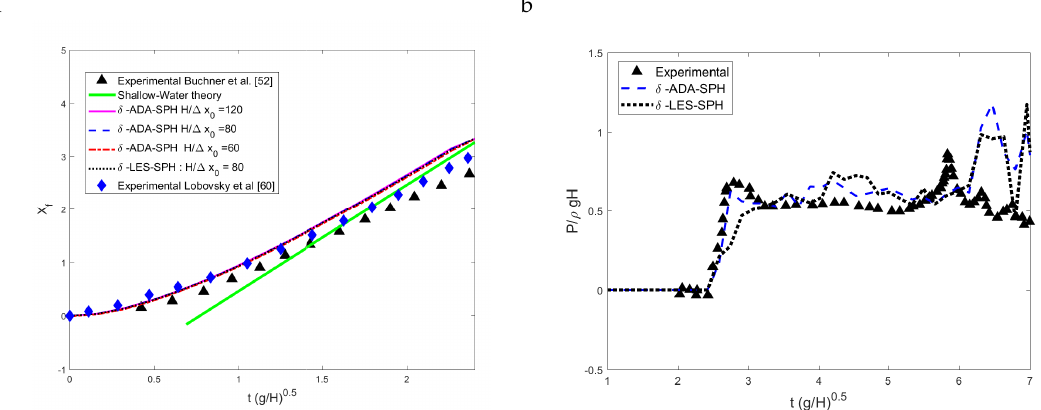
Figure 15. Two-dimensional dam-break flow. Figure ( a ) shows the time evolution of the water front. The green solid line shows the analytical solution from shallow water theory [57] and the black triangles shows the experimental data given by Buchner [49]. The blue diamond shows the experimental data given by Lobovsk`y et al. [58]. Magenta (solid), blue (dashed) and red (dash-dot) lines shows the results obtained by the proposed scheme with H / ∆ x 0 = 120,80 and 60, respectively. Figure ( b ) shows the time evolution of the pressure signals recorded at P is presented. The blue dashed line presents the results obtained by using the presented δ -ADA-SPH model. The magenta dotted line presents the results obtained with δ -LES-SPH approach. The particle resolution is H / ∆ x 0 =